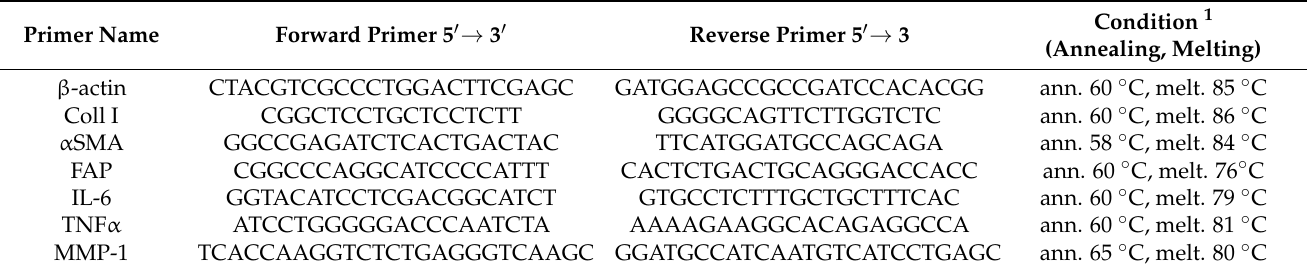
Table 1. Human primers and